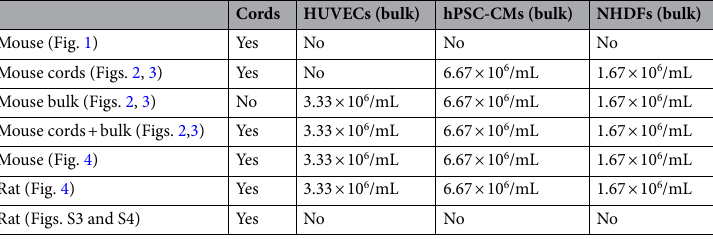
Table 1. Cell types contained in patches for each